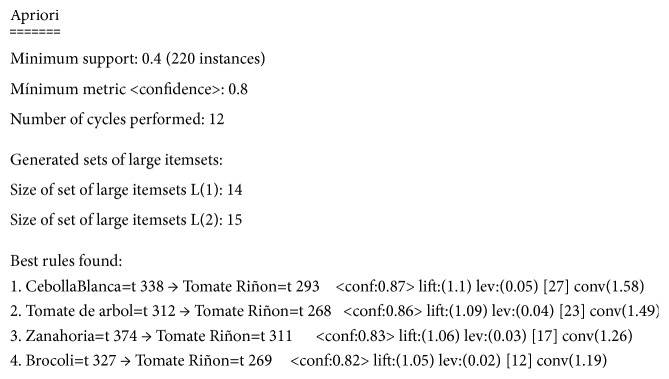
Association rules.